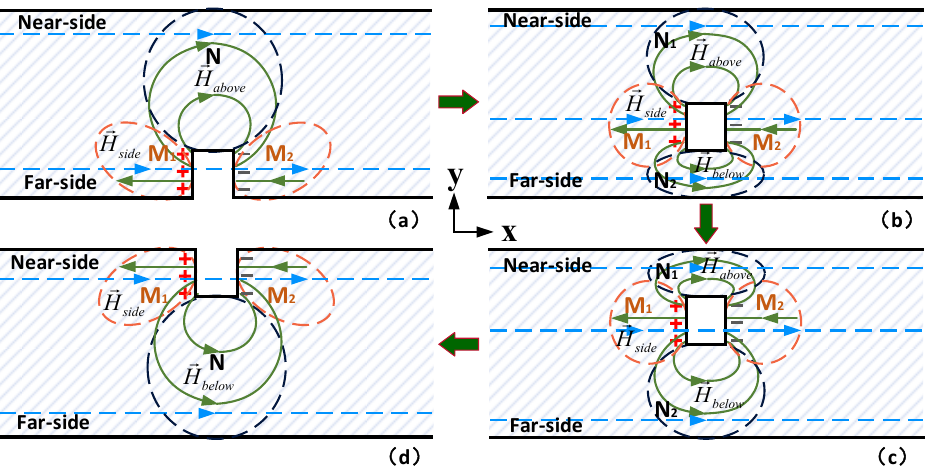
Figure 6. Schematic diagram of magnetic field perturbation of defects of different buried depths. ( a ) far-side surface defect; ( b , c ) internal non-surface opening defects; ( d ) near-side surface defect.